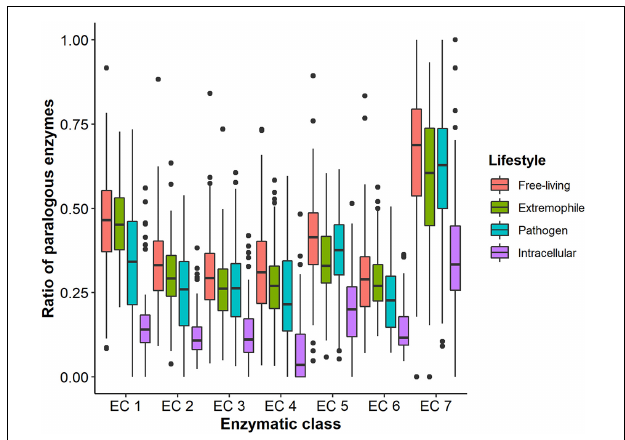
FIGURE 4 | Boxplot showing the comparison of the average paralogous-enzymes ratio across the different lifestyles. Black dots represent the outliers that are found within each lifestyle. Interestingly, the lifestyle within which we found the highest number of outliers was in the intracellular